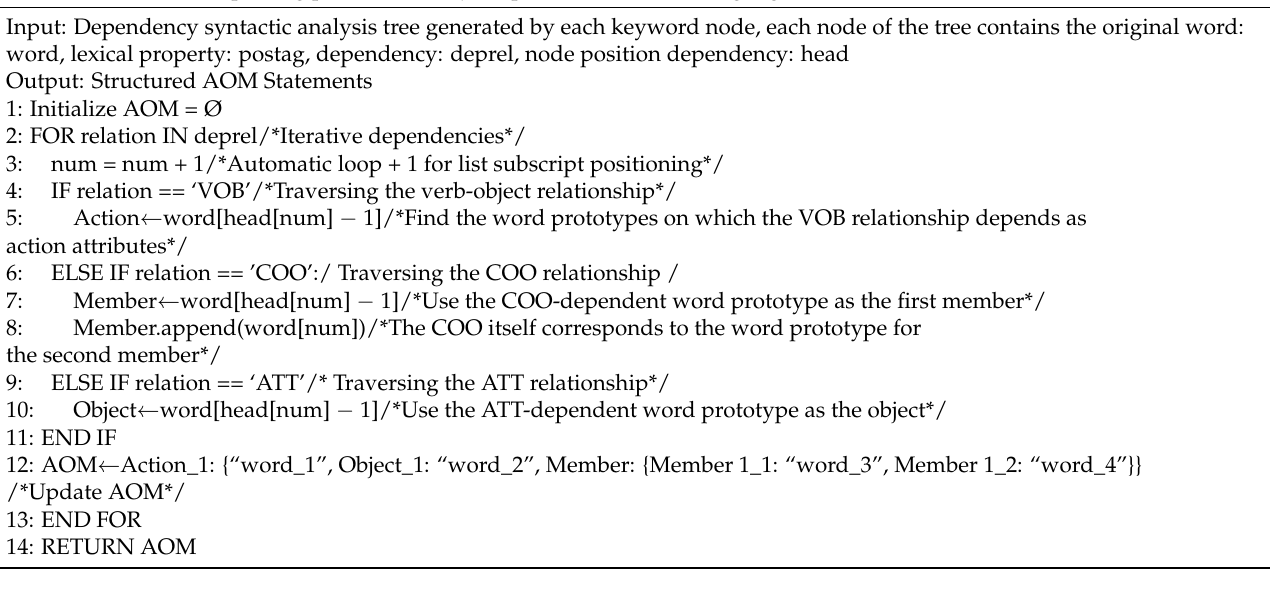
Algorithm 3 Semantic parsing process for the juxtaposition of natural language commands for members.